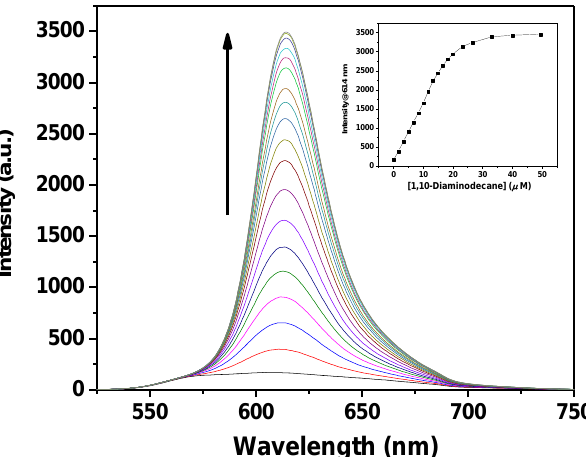
Figure 2. Fluorescence titration curves of 1 (15 µM solution in CHCl 3 ; λ exc = 516 nm) with addition of 1,10-diaminodecane. The concentration of 1,10-diaminodecane added varied from 0 to 50 µM. Inset: variation of the fluorescence intensity at 614 nm as a function of the concentration of 1,10-diaminodecane added.